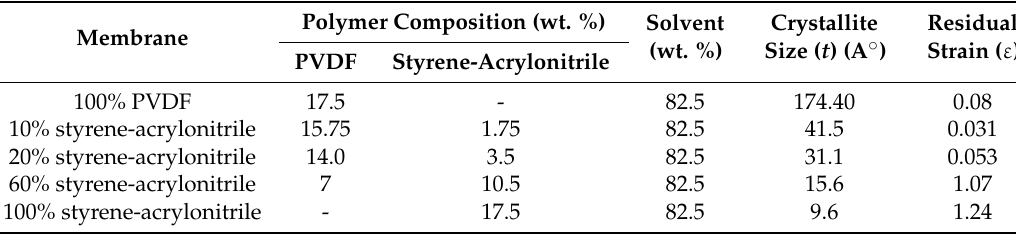
Table 1. Compositions of poly(vinylidene fluoride) (PVDF)/styrene-acrylonitrile blend membranes. Membrane